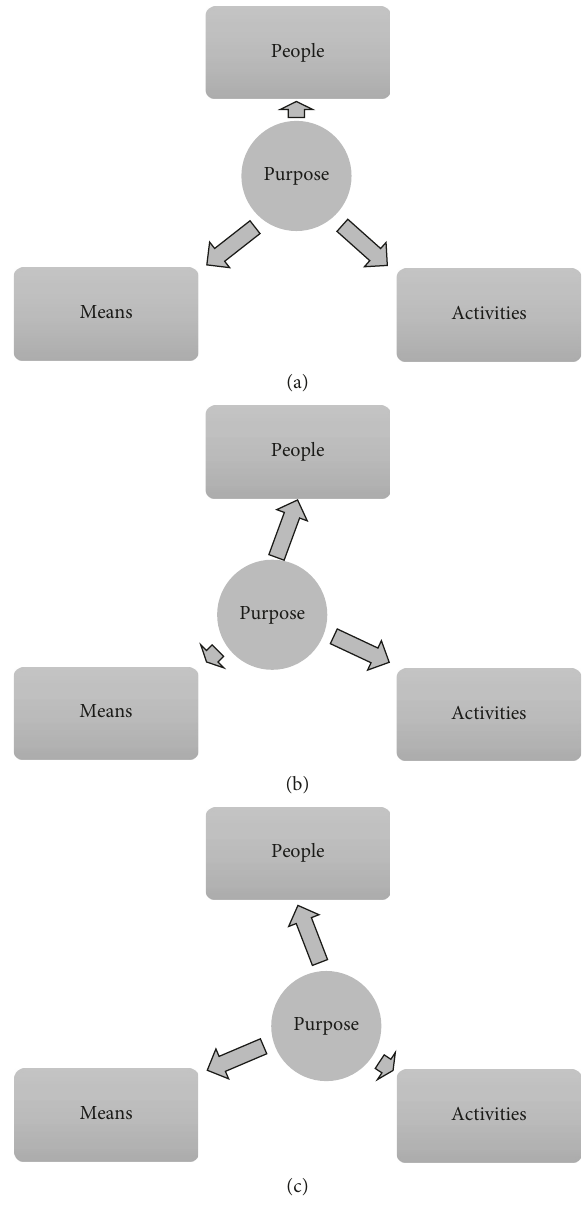
Figure 2: Representation of people-focused (a), means-focused (b), and activities-focused (c)